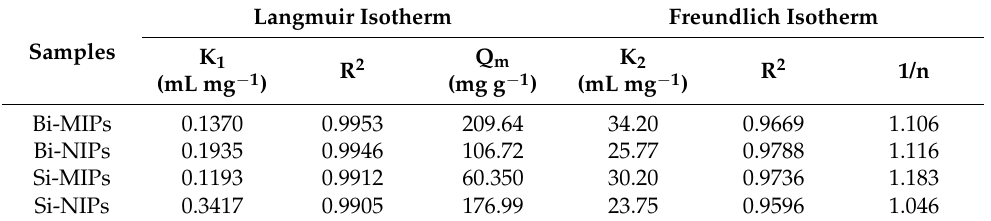
Table 1. Parameters of the Langmuir and Freundlich adsorption models.